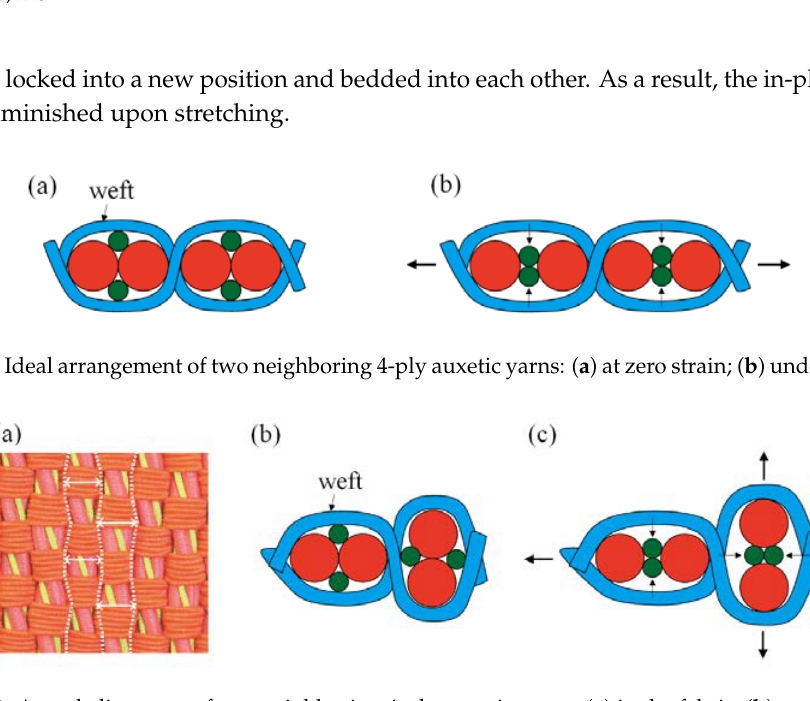
Figure 10. Actual alignment of two neighboring 4-ply auxetic yarns: ( a ) in the fabric; ( b ) at zero strain; ( c ) under tension.